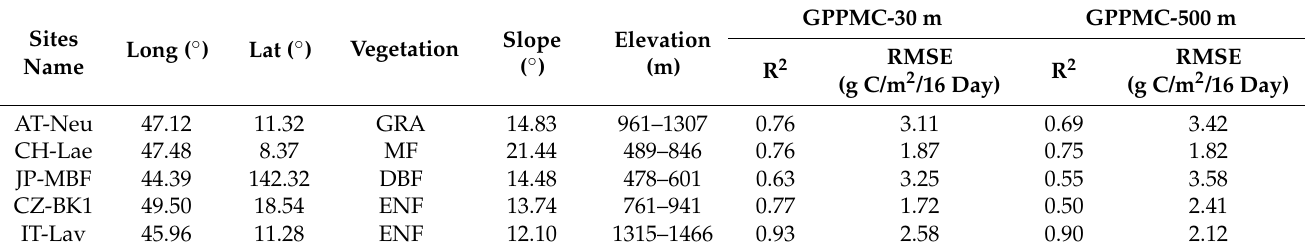
Table 2. Mountain site information and the value of R 2 and RMSE of the model performance at 30 m and 500 m resolution, respectively.